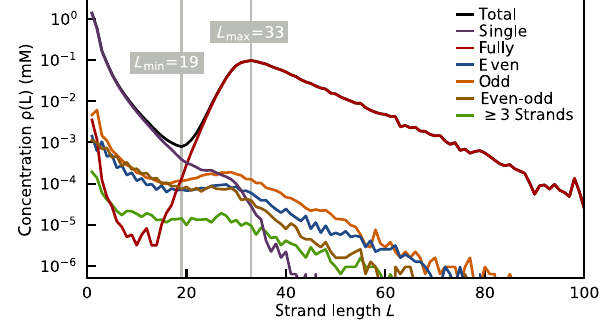
FIG. 5. Partitioned length distribution for a system coupled to a reservoir containing monomers and dimers at a monomer fraction of f m ¼ 0 . 7 . In contrast to Fig. 4, virtually all strands with L > L (cid:1) belong to a fully hybridized